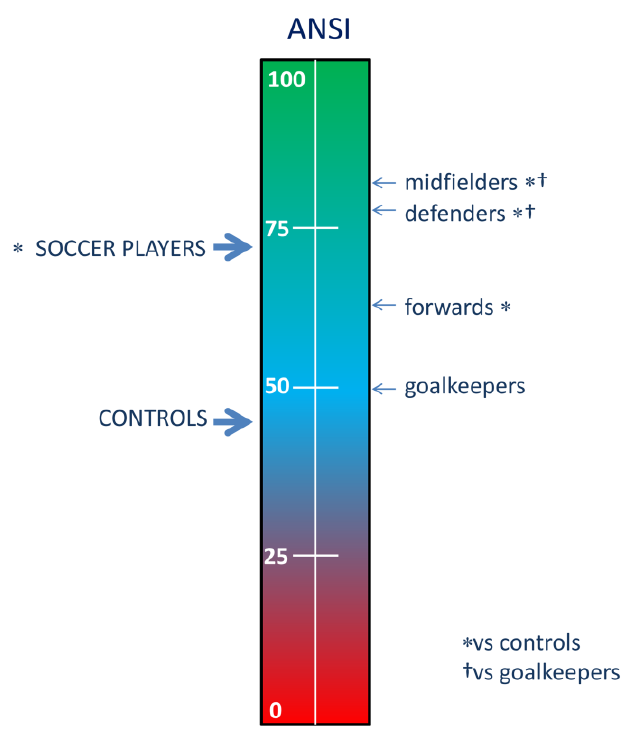
Figure 2. Different values of the unitary autonomic nervous system index (ANSI) in controls and Italian A team soccer players, according to playing position. * and † indicate significance versus respectively controls and goalkeepers. Table 3. Individual autonomic proxies according to playing position in an Italian Serie A soccer team. Variable